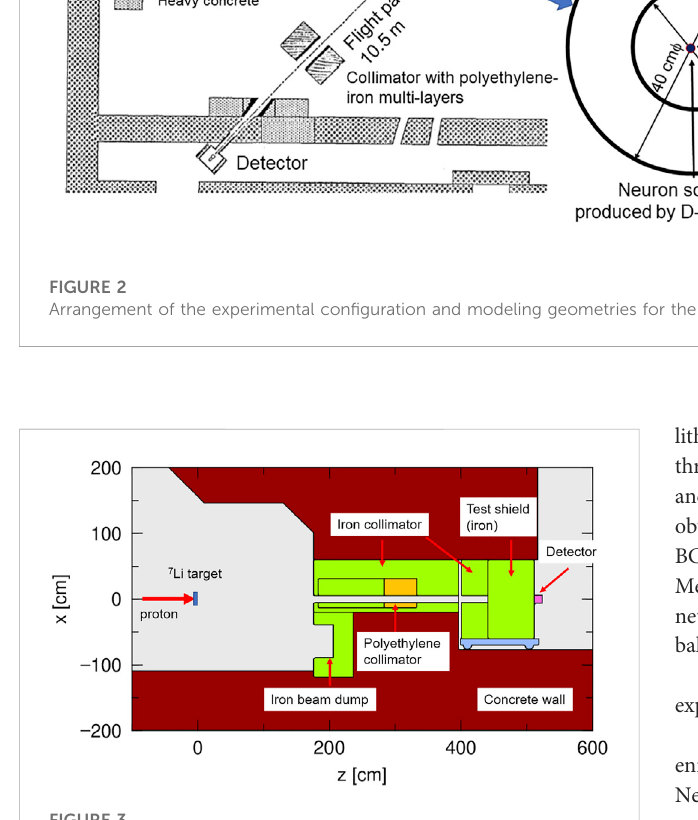
FIGURE 3 GeometryinPHITScalculationsfortheTIARAexperiments.Thetest shield is either an iron shield or a concrete